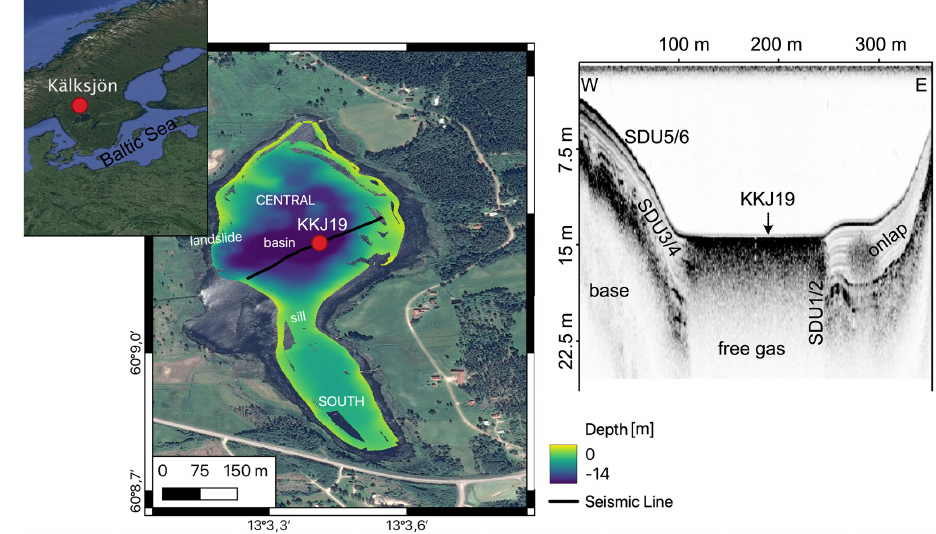
Figure 1. Geographical location of Lake Kälksjön (KKJ) in the western Baltic region and a bathymetric map of the basin with the coring location of composite profile KKJ19 (© 2015 Google Maps). A seismic line crossing the coring location displays the sedimentary sequence of KKJ. The expected seismic reflections of the six sediment deposition units (SDUs) in KKJ19 are indicated.